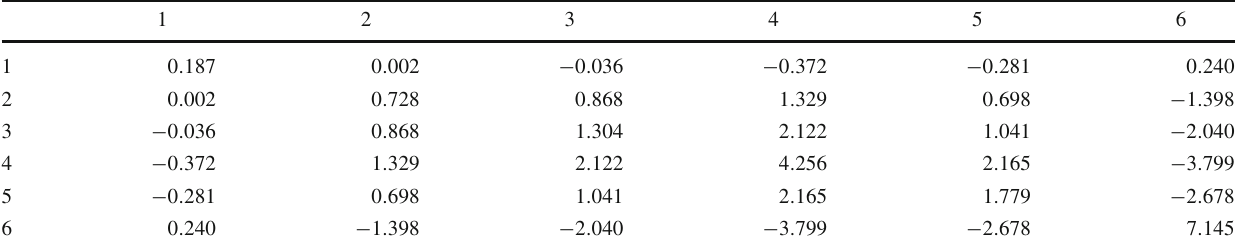
Table 3 Fractional error matrix (cid:9) δ R i δ R j (cid:10) /( R i R j ) obtained from the systematic uncertainties on the far-to-near flux predictions. The neutrino energy binning is same as in Table 2. The values are written in the unit of 10 − 3